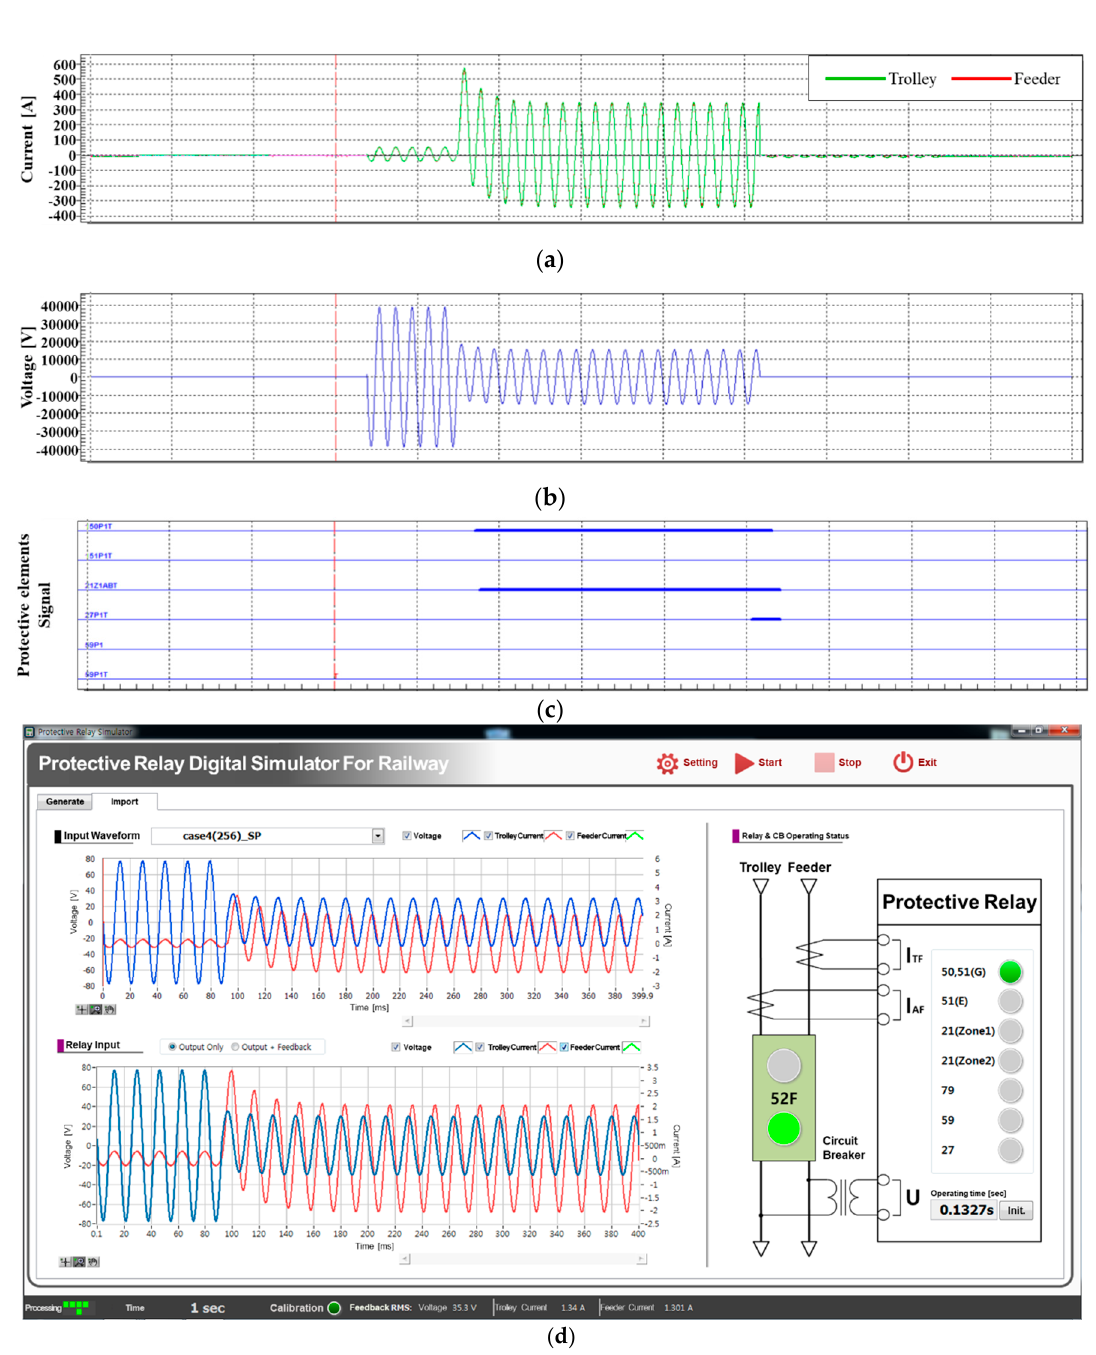
Figure 18. Simulation results for Case 4: ( a ) Input current; ( b ) Input voltage; ( c ) Protective relay signal; and ( d ) Digital simulator interface results.